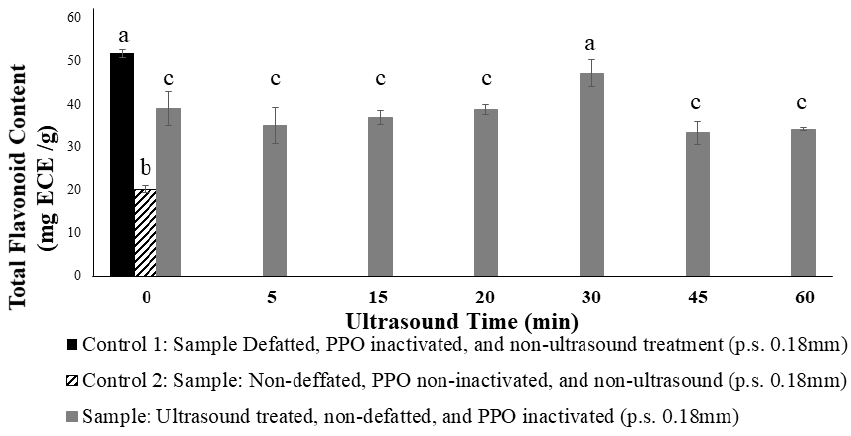
Figure 1. Impact of time of ultrasonic treatment on total polyphenolic amount. Means with different letters were significantly different by Tukey (p < 0.05).